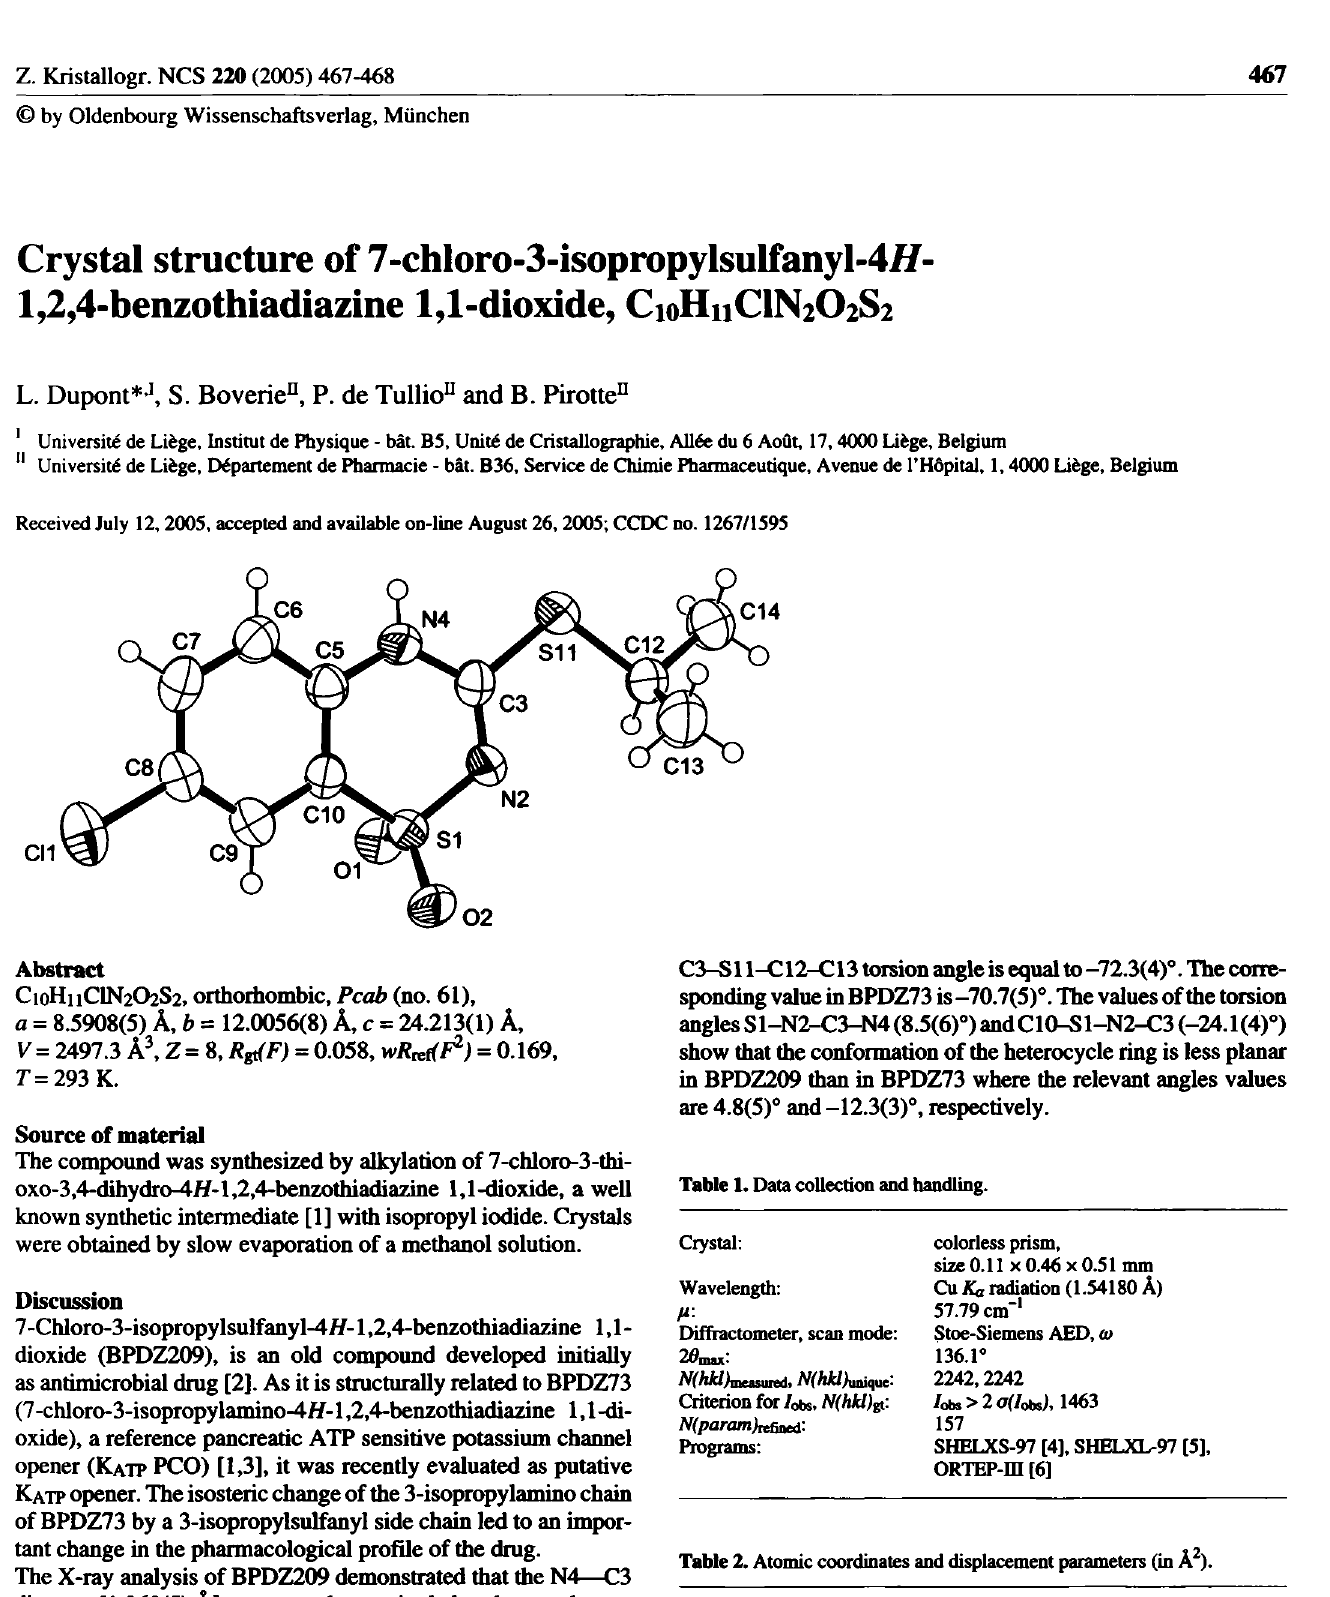
Table 2. Atomic coordinates and displacement parameters (in Ä 2